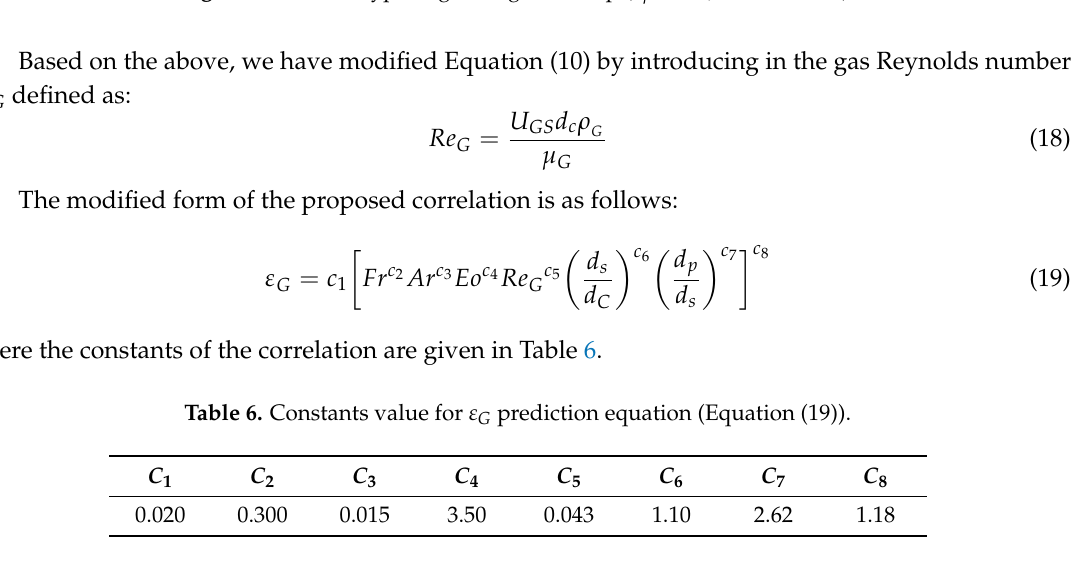
Table 6. Constants value for ε